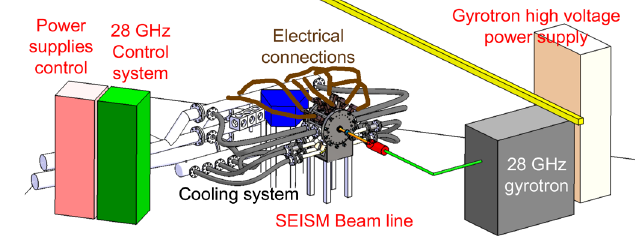
FIG. 31. Schematic view of the beam experiment